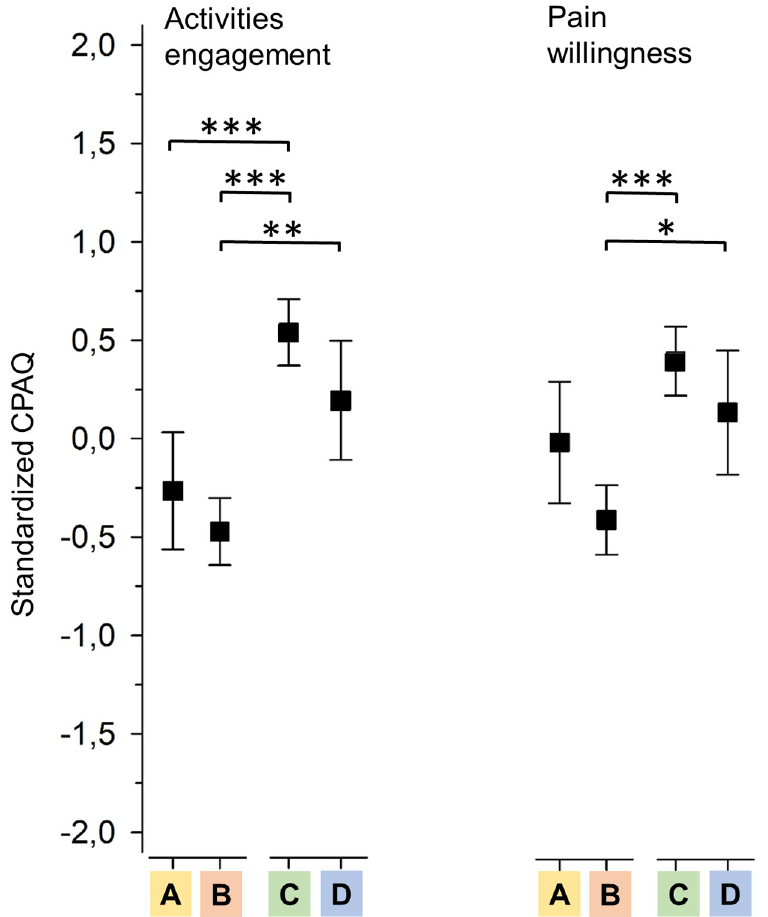
Fig 4. Standardized Chronic Pain Acceptance Questionnaire (CPAQ) subscale means with respect to different interference groups. A = activity low, affective high; B = activity high, affective high; C = activity low, affective low; D = activity high, affective low. Asterisks denote significant group differences: � = P < 0.05; �� = P < 0.01; ��� = P < 0.001. Box plot whiskers represent 95% confidence intervals.